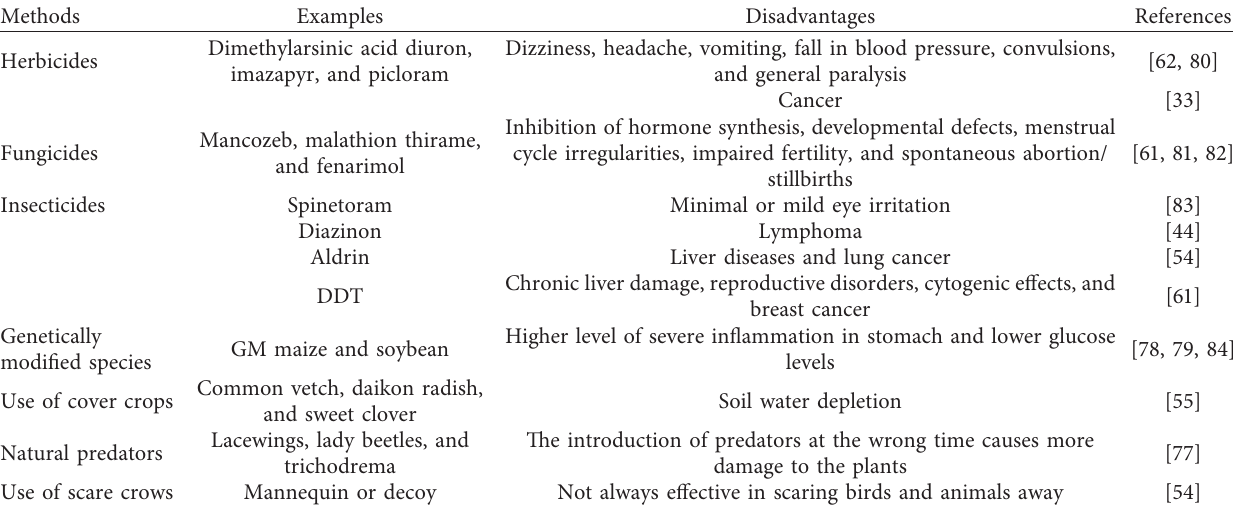
Table 2: Negative effects of current methods of crop